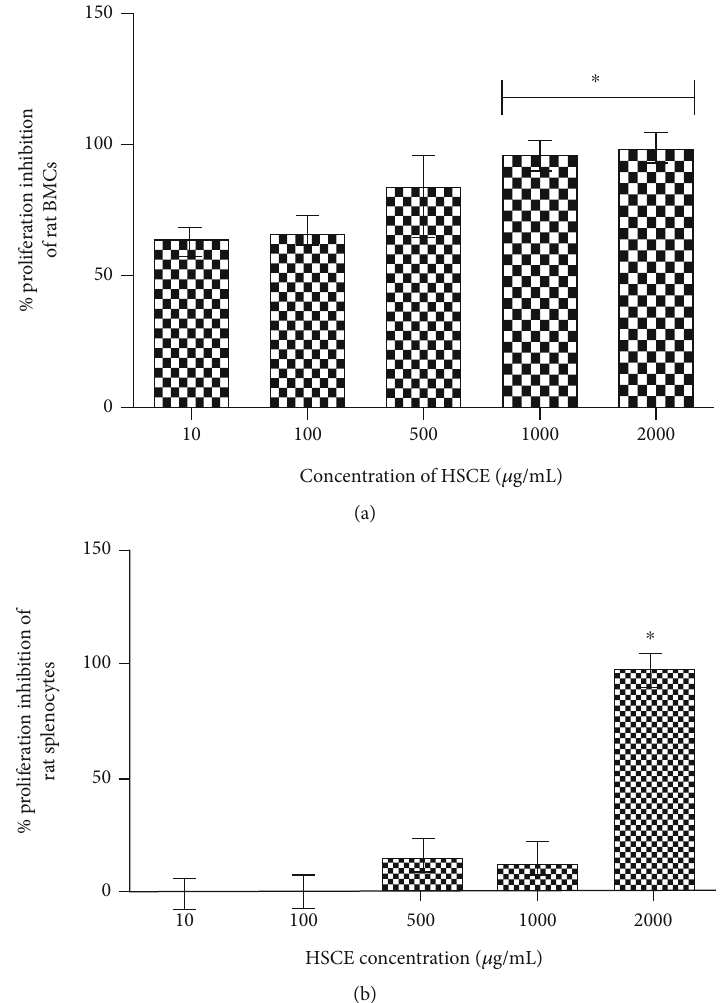
Figure 4: E ff ect of Haliclona ( Soestella ) sp. sponge crude extract (HSCE) on ex vivo proliferation of rat (a) bone marrow cells (BMCs) and (b) splenocytes ( ∗ p < 0 : 01 ; Mann-Whitney U